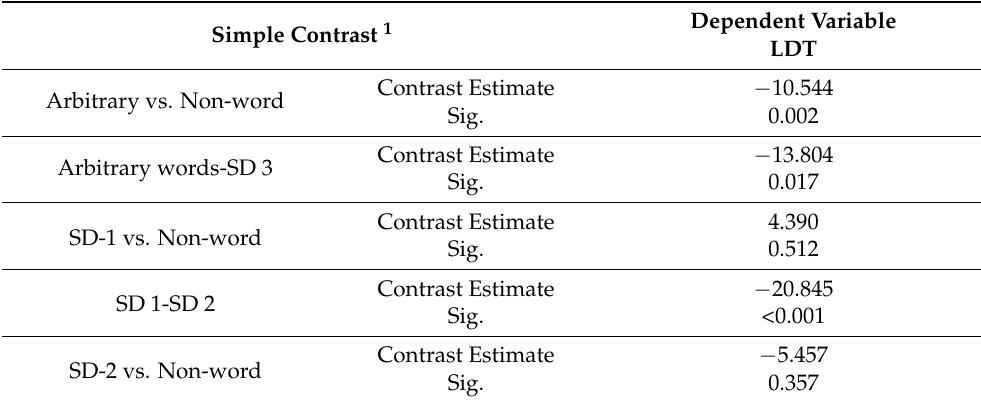
Table 10. Comparison of the Reaction Time to Non-Words and Target Stimuli in English.